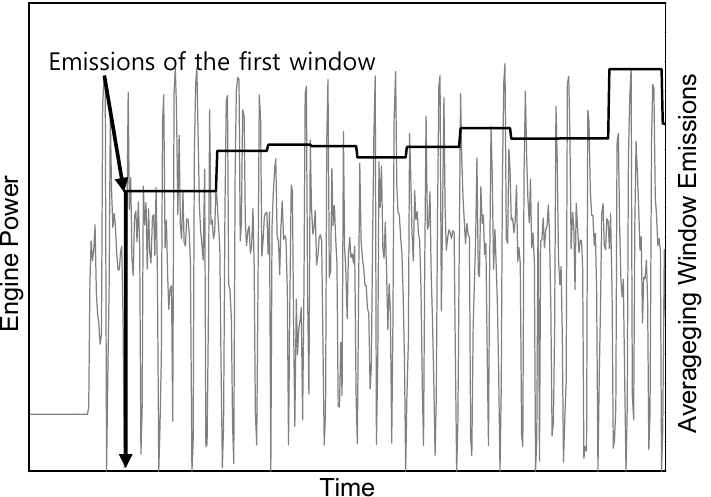
Figure 2. Engine power, time, and averaging window gaseous emissions, starting from the first averaging window.